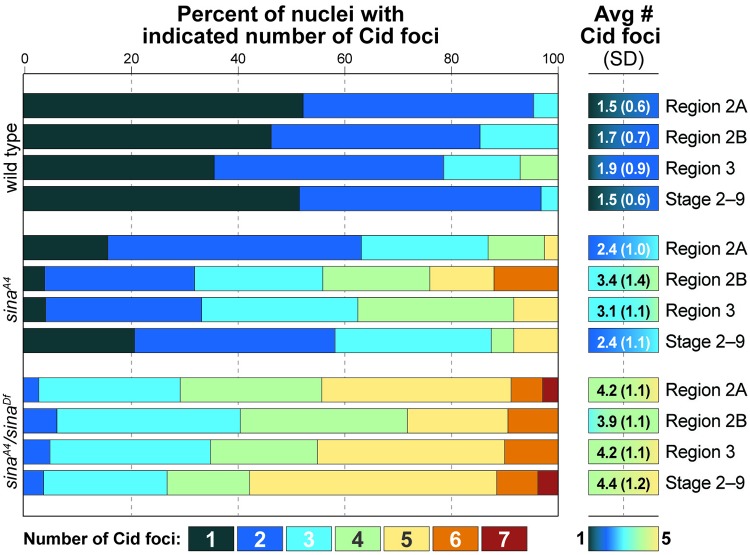
Centromere clustering is abnormal in sinaA4/sinaDf mutants.The percentage of nuclei showing the indicated number of centromere clusters is displayed by color with centromere cluster average and standard deviation on the right. Number of nuclei scored for wild type: 65 (region 2A), 41 (region 2B), 14 (region 3), and 31 (stages 2–9); sinaA4: 38 (region 2A), 25 (2B), 24 (Region 3), and 24 (Stages 2–9); sinaA4/sinaDf 34 (region 2A), 32 (region 2B), 20 (region 3), and 26 (stages 2–9). For both sinaA4 and sinaA4/sinaDf nuclei, centromere clustering was significantly different at all stages from wild type of the same stage at p values of <0.05 (statistical test, two-tailed Mann-Whitney test).